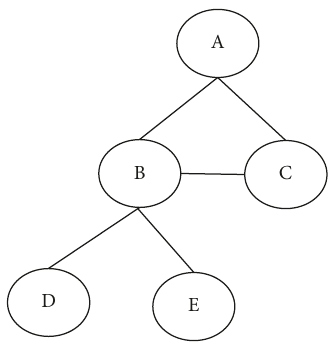
Figure 6: The MG of the BN in Figure 1.